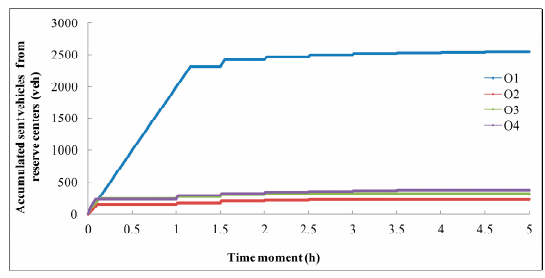
Figure 11. The accumulated sent materials of each reserve center, considering dynamic material supply.